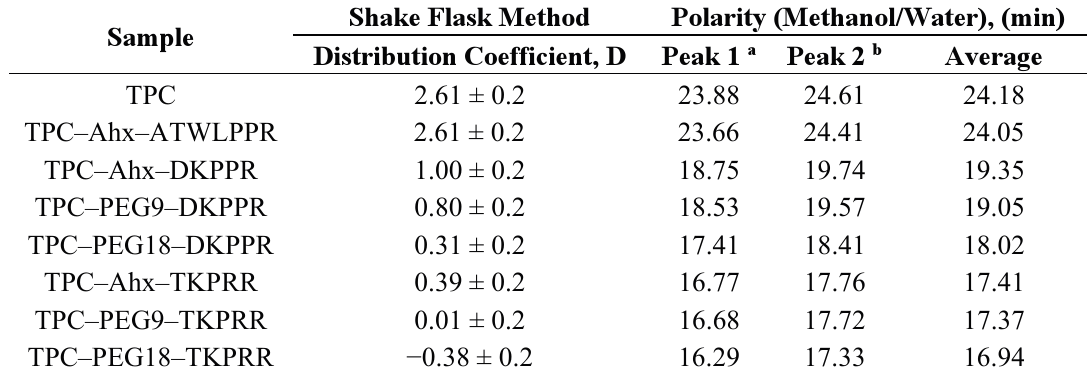
Table 2. Log D values and retention time of TPC and the respective conjugates in reverse phase